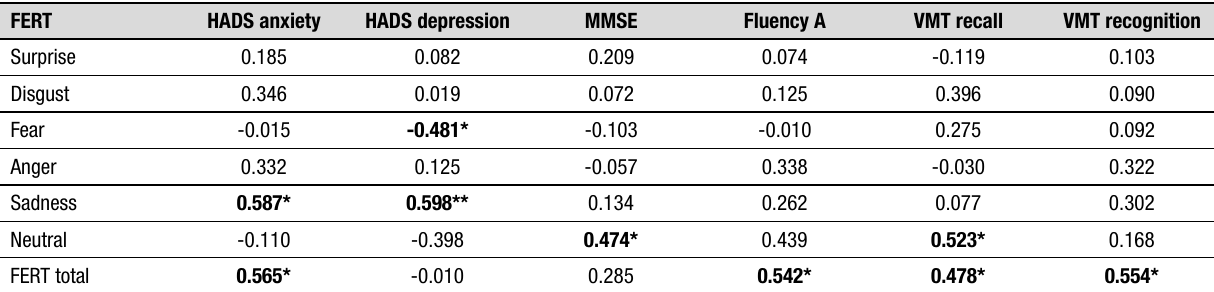
Table 2. Spearman correlation between Facial Emotion Recognition Test with cognitive and behavioral tests at stroke follow-up group (n=18). FERT